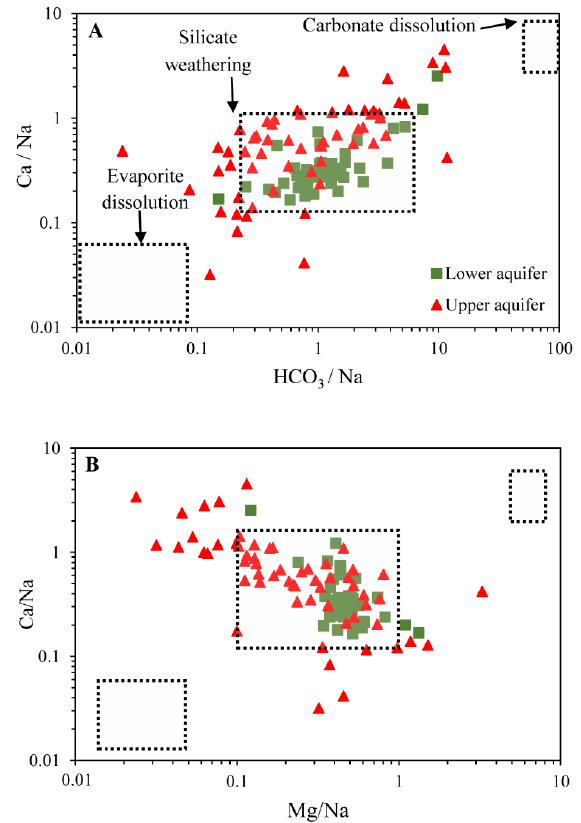
Figure 8. Bivariate plots of molar ratio according to [53–55]. ( A ) Na-normalized Ca versus Na-normalized HCO 3 . ( B ) Na-normalized Ca versus Na-normalized Mg for upper (red color) and lower (green color) aquifers.